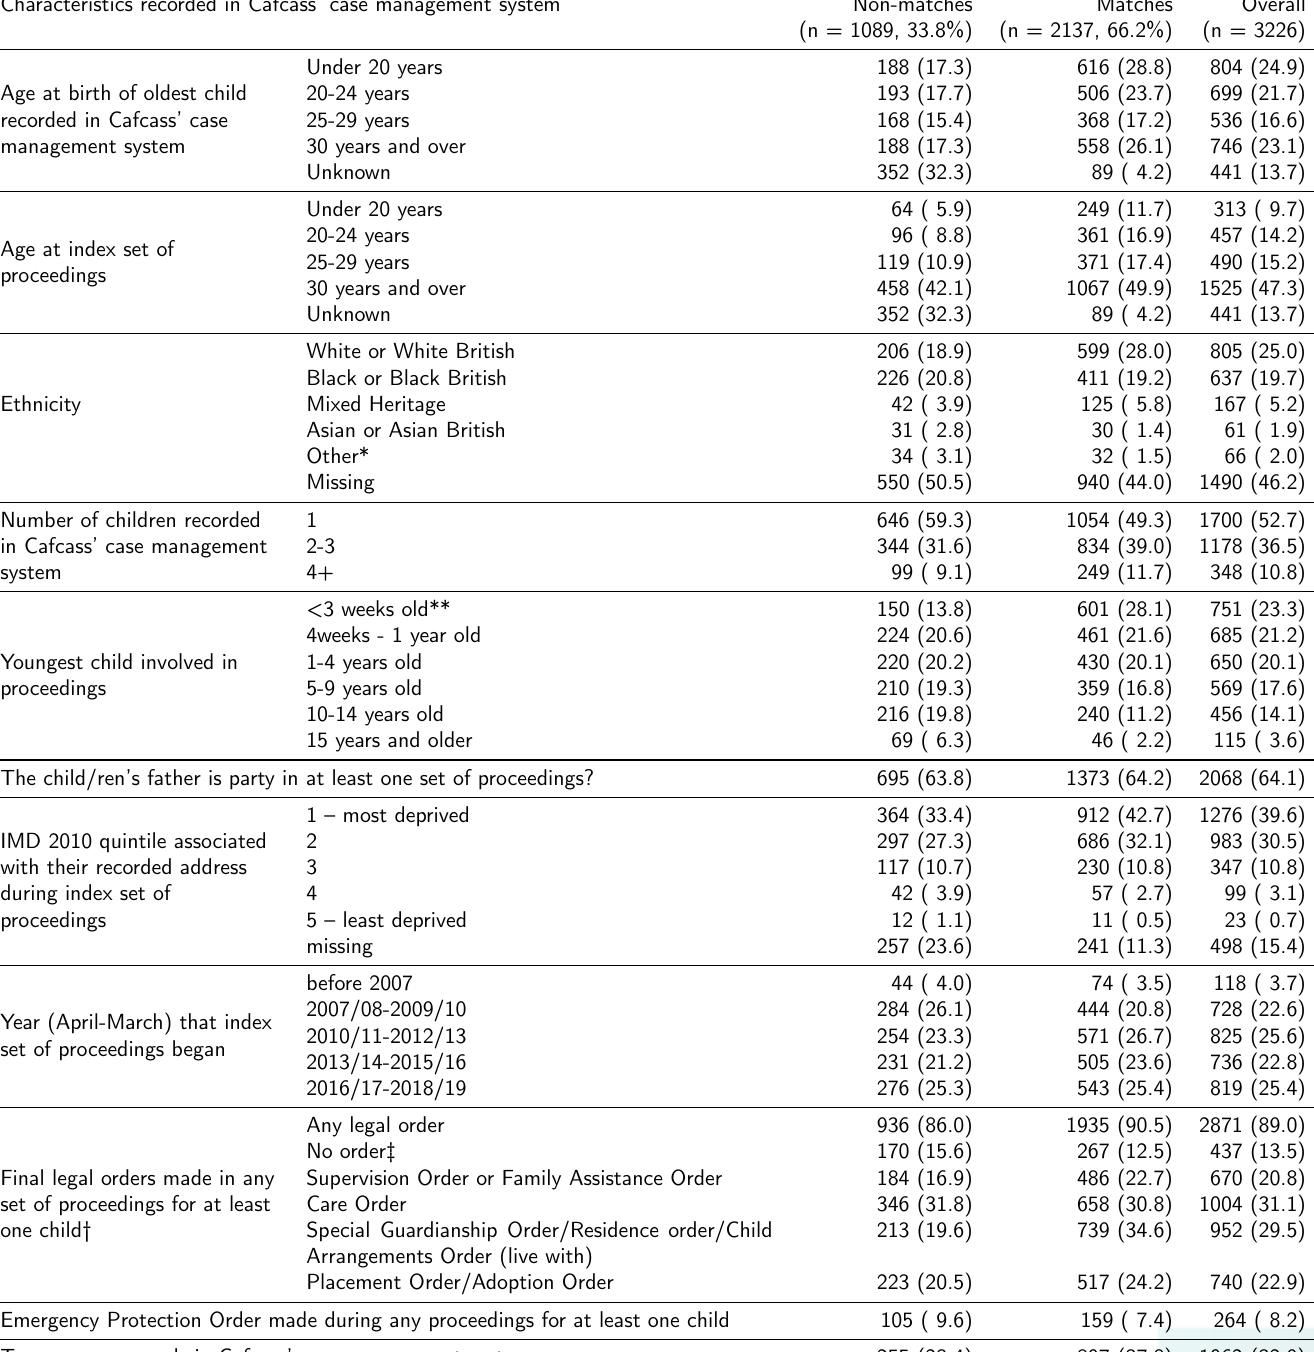
Table 2: Characteristics among women involved in proceedings in Croydon, Lambeth, Lewisham and Southwark between April 2007 and March 2019 (n =